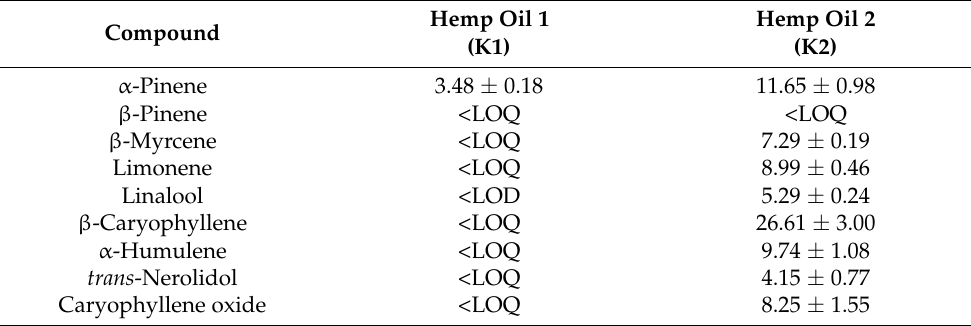
Table 4. Quantification of terpenes in hemp oils using GC-MS. Data expressed as µ g/mL ±